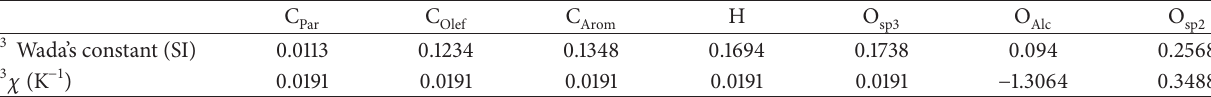
Table 7: Atomic contribution values and temperature correction coefficients